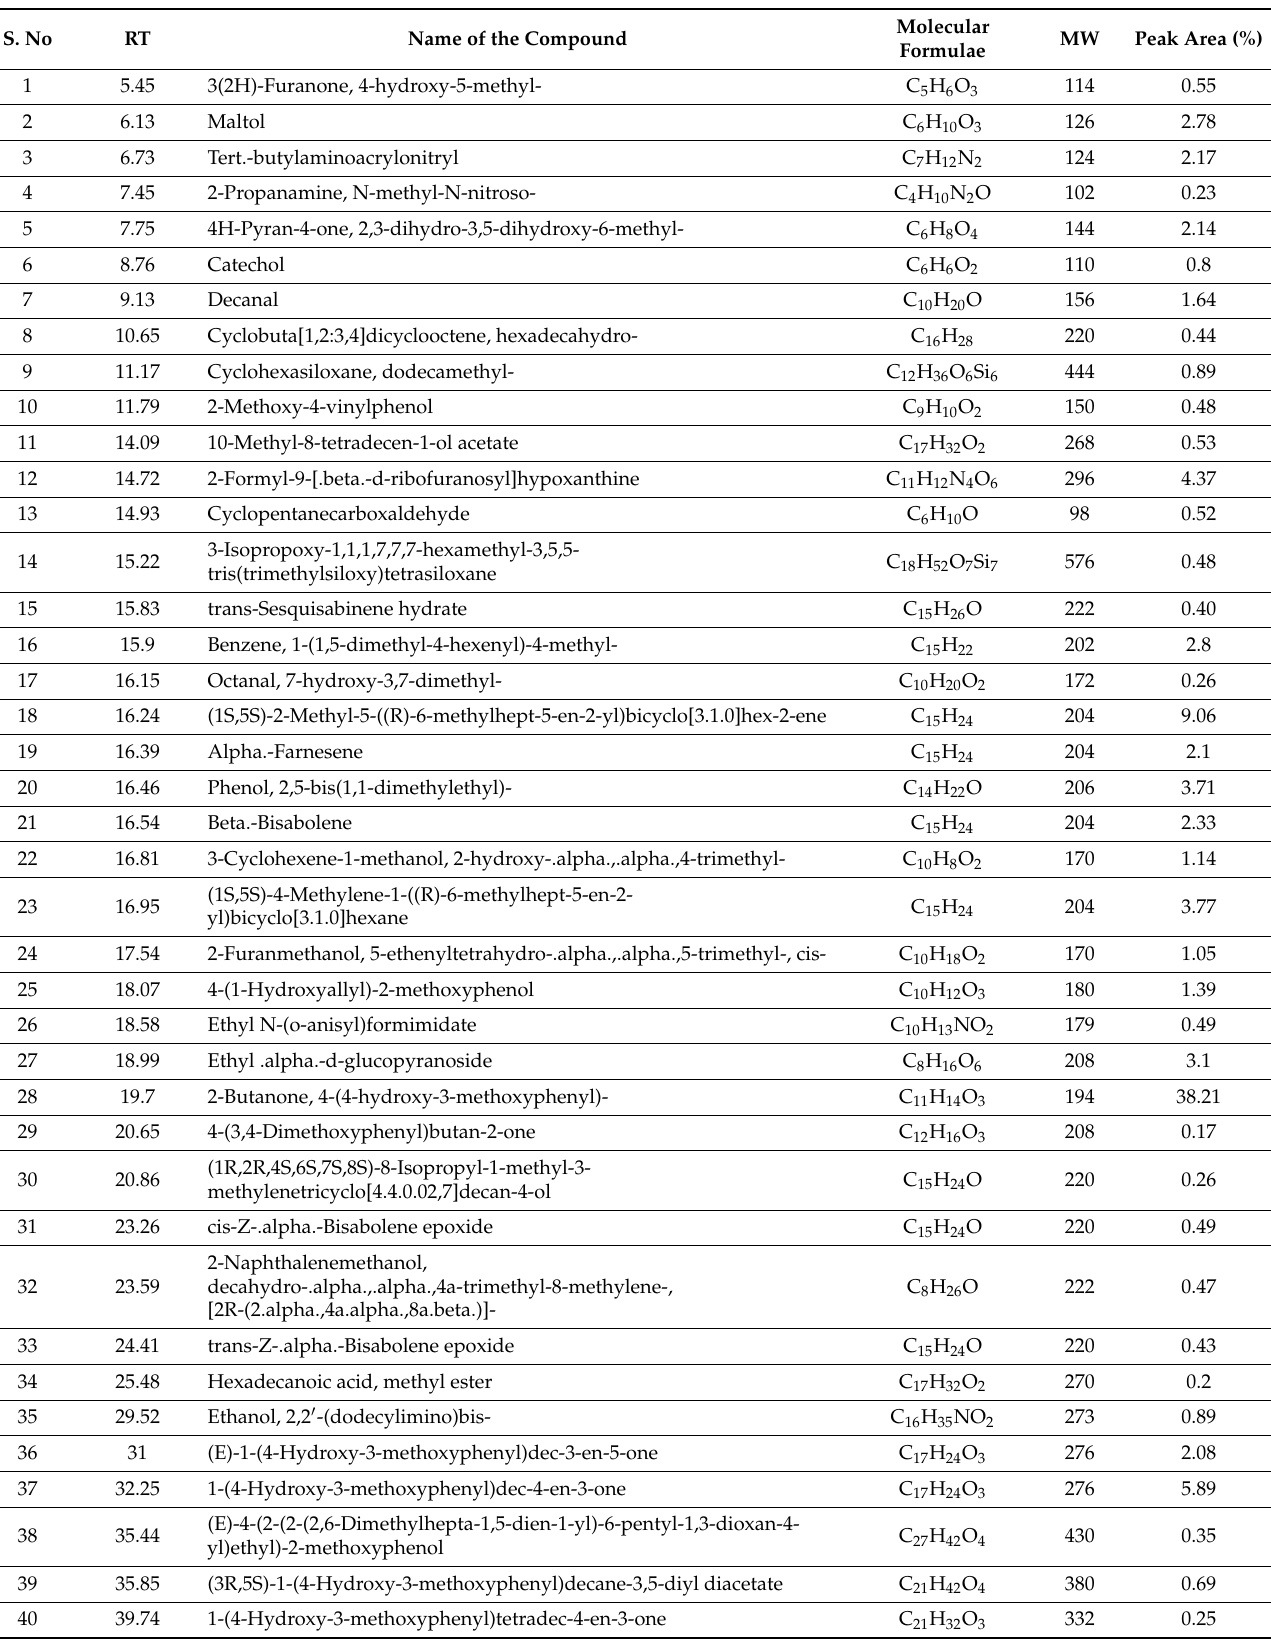
Table 6. Compounds are identified in water-extracted Z. officinale